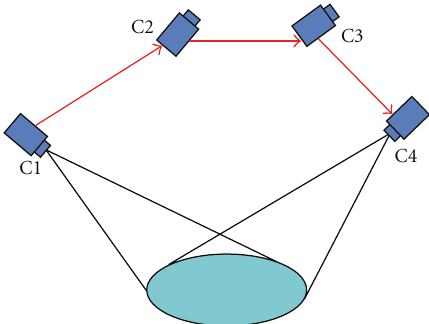
Figure 4: Cameras C1 and C4 observe the same part of the scene, but are not in communication range of each other. Thus, data routing is performed over other camera nodes